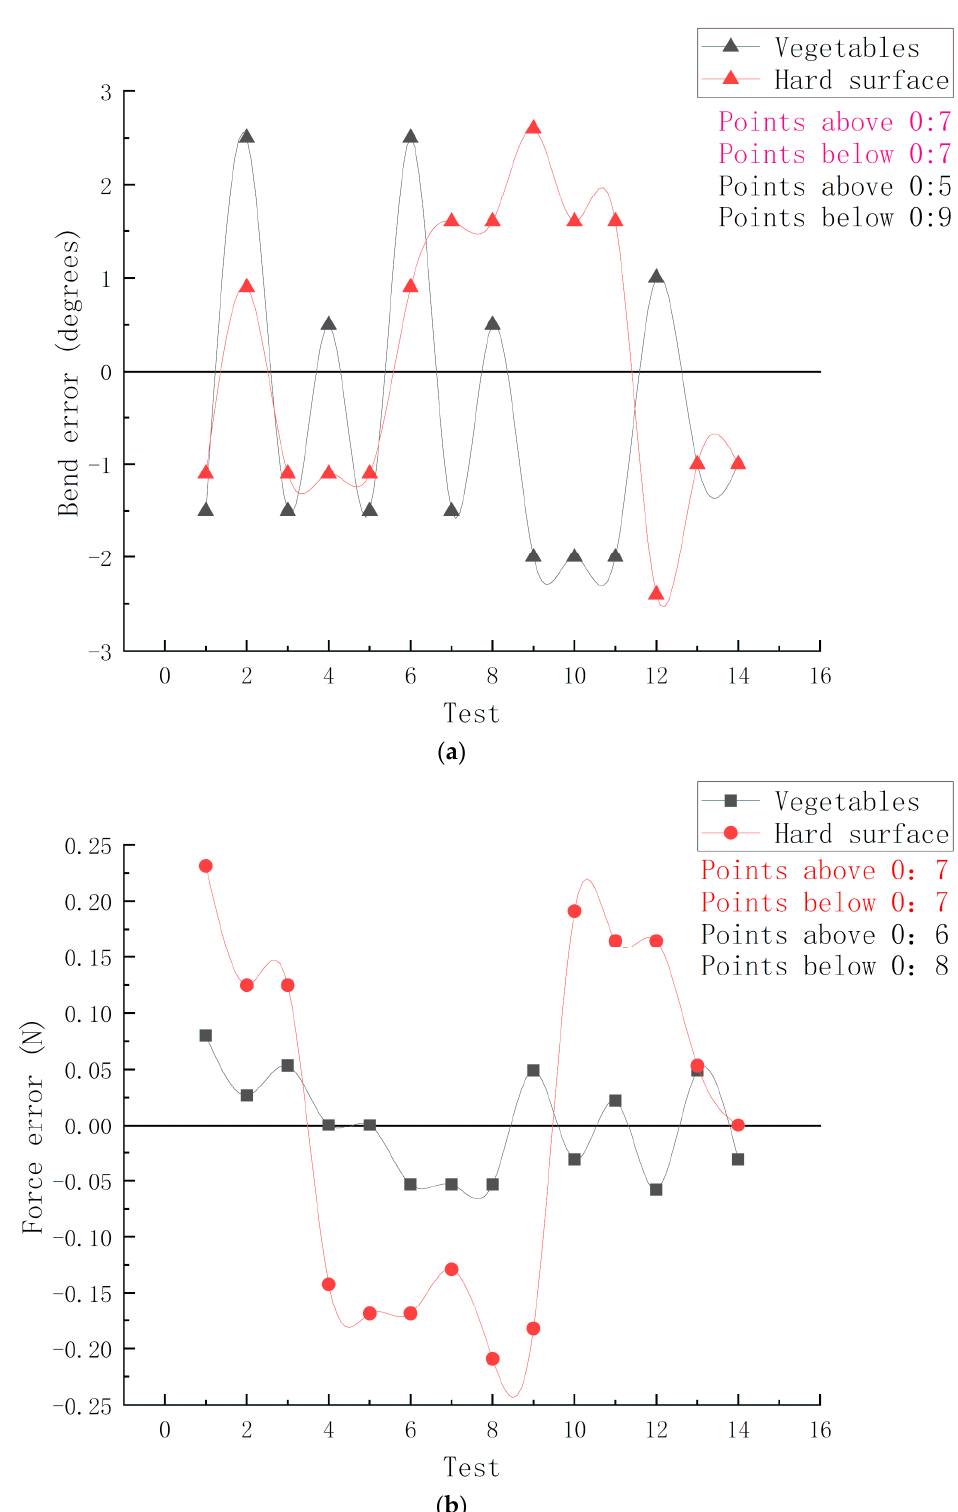
Figure 13. The relationship between measurement error and material. ( a ) The error distribution of bending angle. ( b ) The error distribution of force.